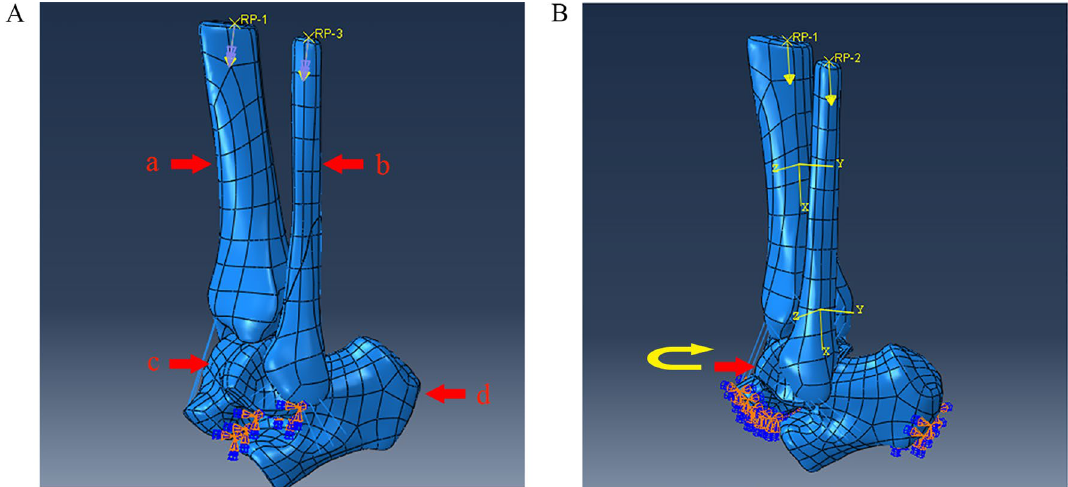
Figure 2. Boundary constraints and load diagram of the damage model analysis. ( A ) Boundary constraints. ( B ) The load conditions set. a: Tibia. b: Fibula. c: Talus. d: Calcaneus. The yellow arrow indicates the internal rotation moment to the